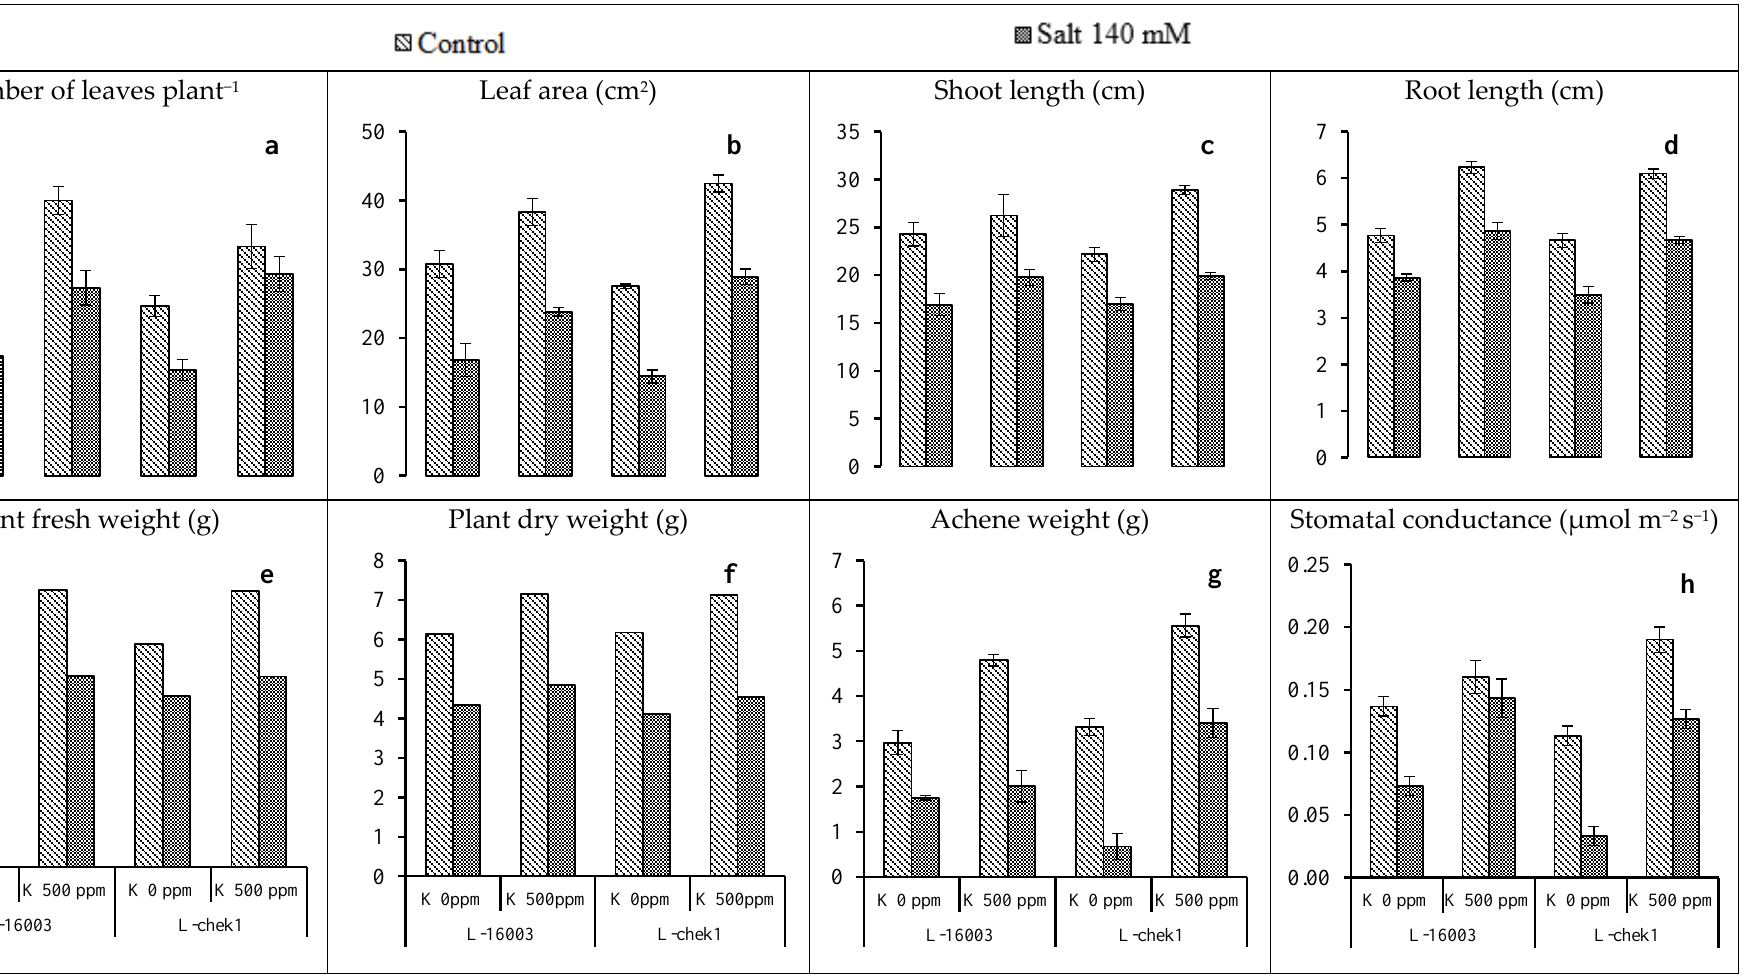
Figure 1. Impact of foliar applied potassium on the number of leaves per plant −1 : ( a ) leaf area, ( b ) shoot length, ( c ) root length, ( d ) plant fresh weight, ( e ) plant dry weight, ( f ) achene weight, ( g ) and stomatal conductance ( h ) of sunflower hybrids grown under a salinity stress environment.